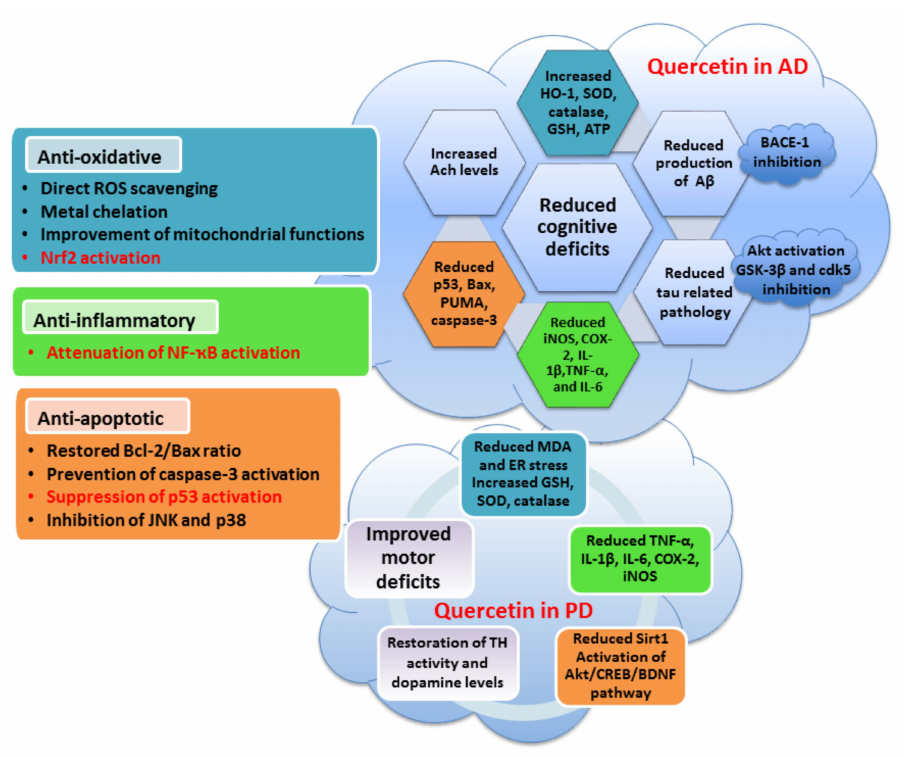
Figure 6. Neuroprotective activities of quercetin in neurodegenerative conditions. Some specific effects of quercetin in Alzheimer’s disease and Parkinson’s disease are